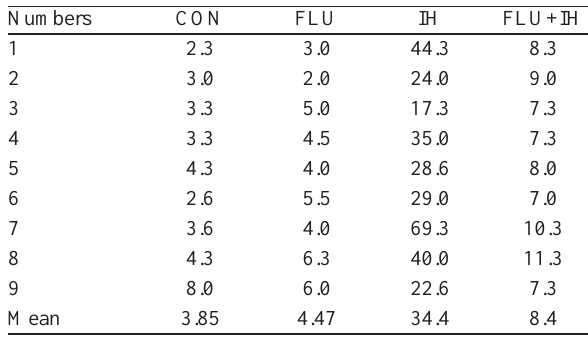
Table 1. Comparative analysis of mitochondrial crystalysis profile number